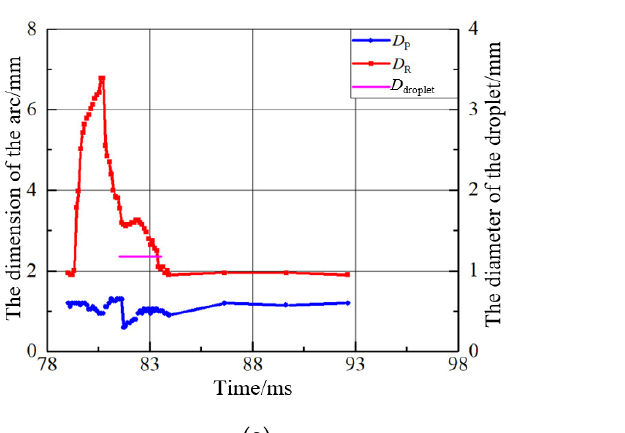
Figure 14. ( a ) The droplet and arc size in different times during a single pulse period (exponential pulse waveform, I = 100 A); ( b ) transient arc pressure and heat input power (exponential pulse waveform, I = 100 A).